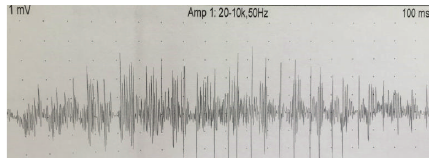
Figure 1: EMG showing spontaneous discharges in the left rectus femoris.